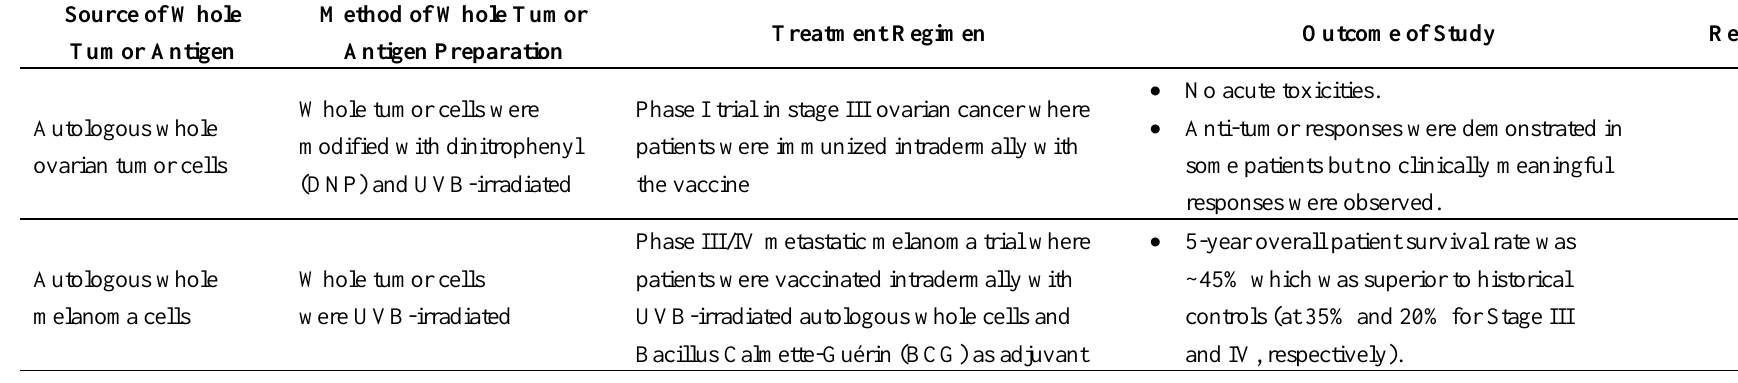
Table 2. Evaluation of different whole tumor antigens in selected published clinical